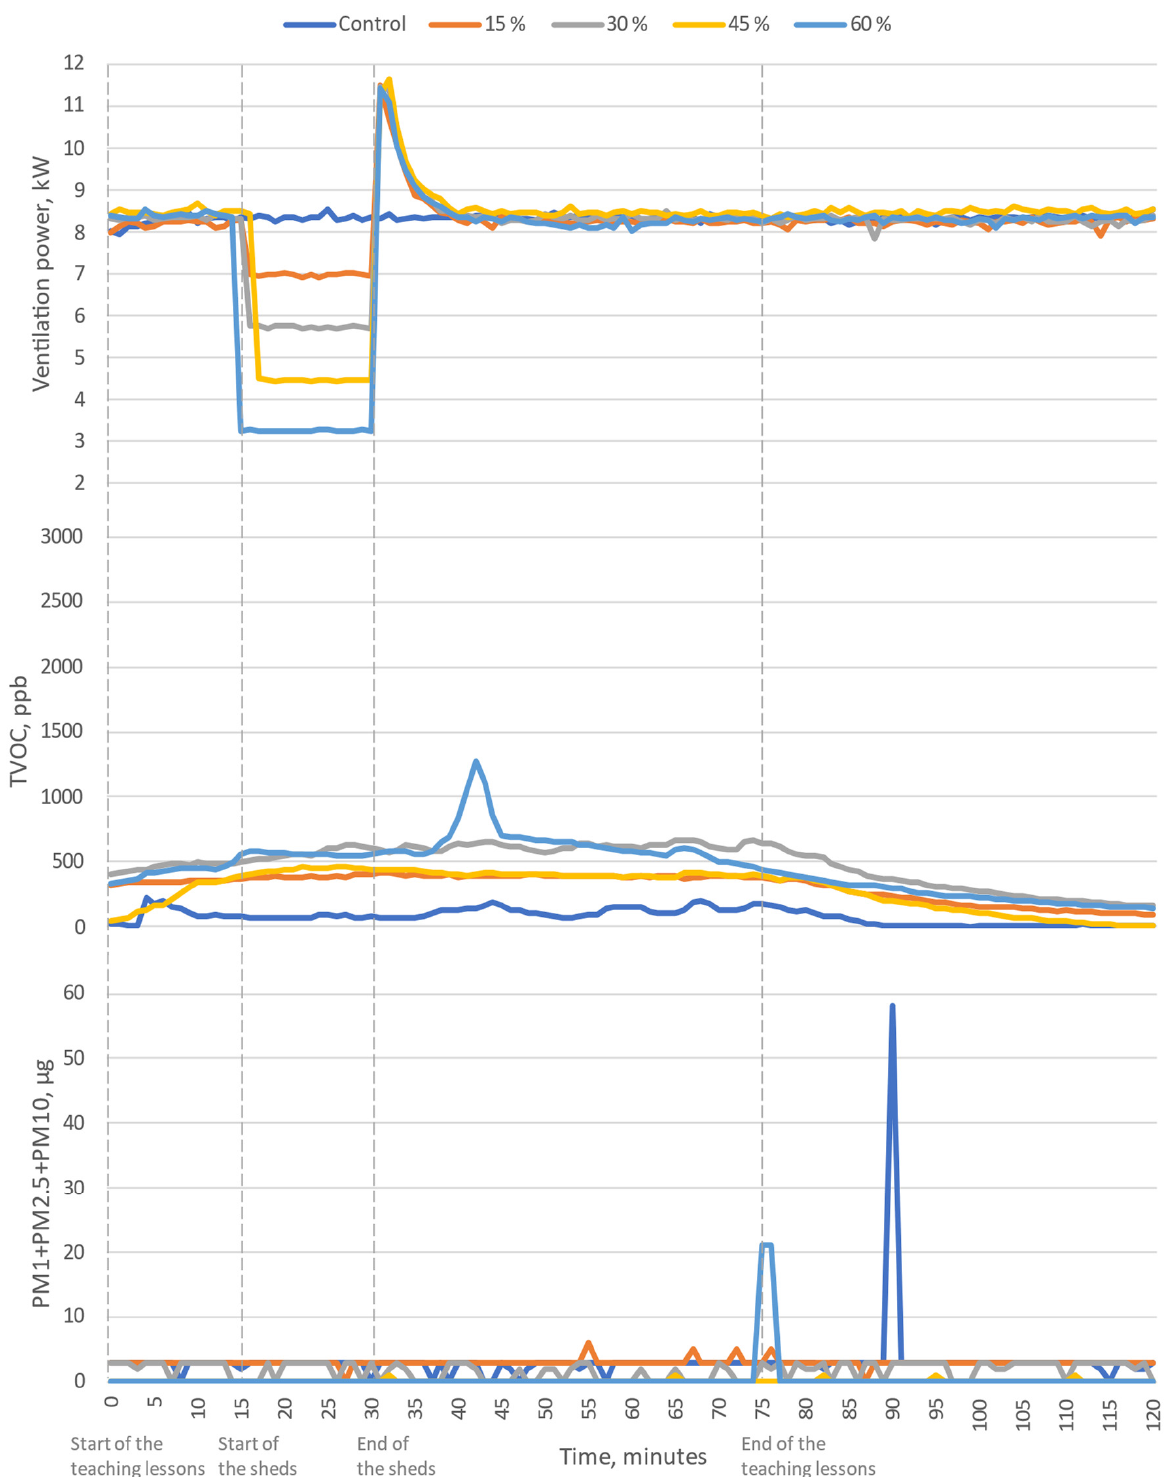
Figure 4. The ventilation power, the indoor TVOC and the particle sensor data obtained from the 15 min tests.